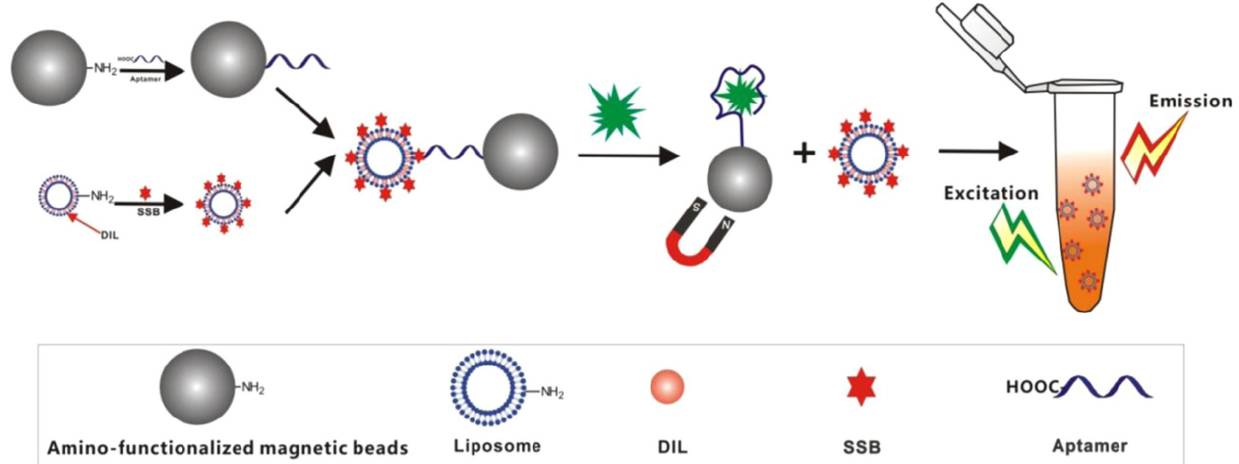
Figure 3. Scheme of a fluorescent biosensor for the CAP assay using a combination of MBs and fluorescent liposomes. Reprinted from [48] with permission from Elsevier.